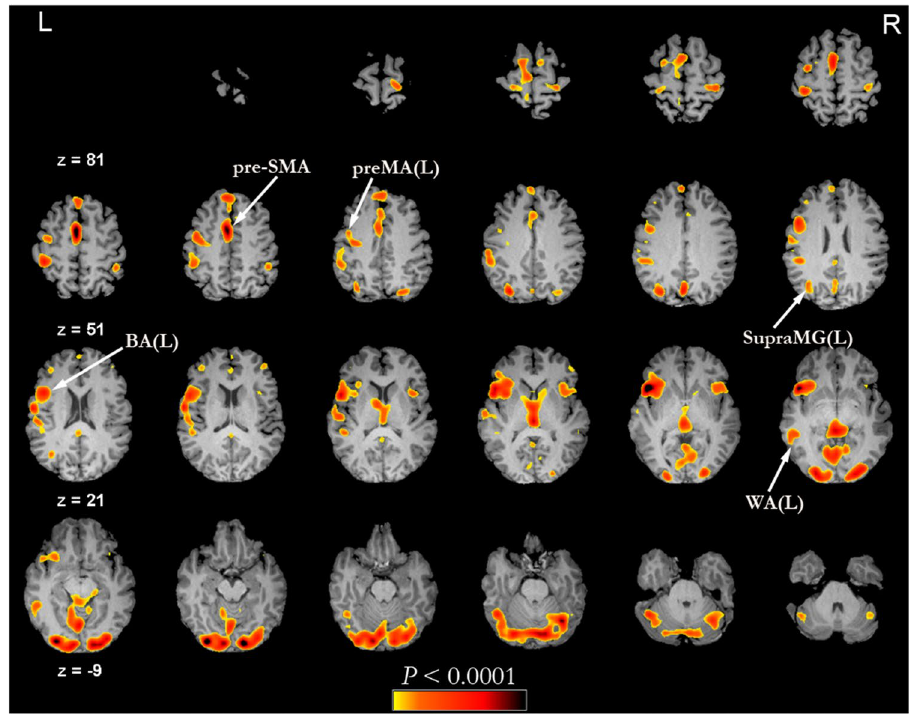
Figure 1. A representative subject’s fMRI activation map overlaid on the anatomical MR image. The reader’s left-hand side is the subject’s left brain hemisphere. The slice number is indicated by z. The areas highlighted in color correspond to fMRI active brain areas and the color bar at the bottom of the figure provide the p -values. Several regions have been labeled according to anatomical location. Areas such as visual cortex, which are unrelated to language but active during the fMRI task, were not included. 3D Clusters were extracted and named according to their anatomical locations, such as left Broca’s Area (BA(L)), left Wernicke’s Area (WA(L)), pre-supplementary motor area (pre-SMA), left premotor area (preMA(L)) and left Supra-Marginal Gyrus (SupraMG(L)), as marked on the